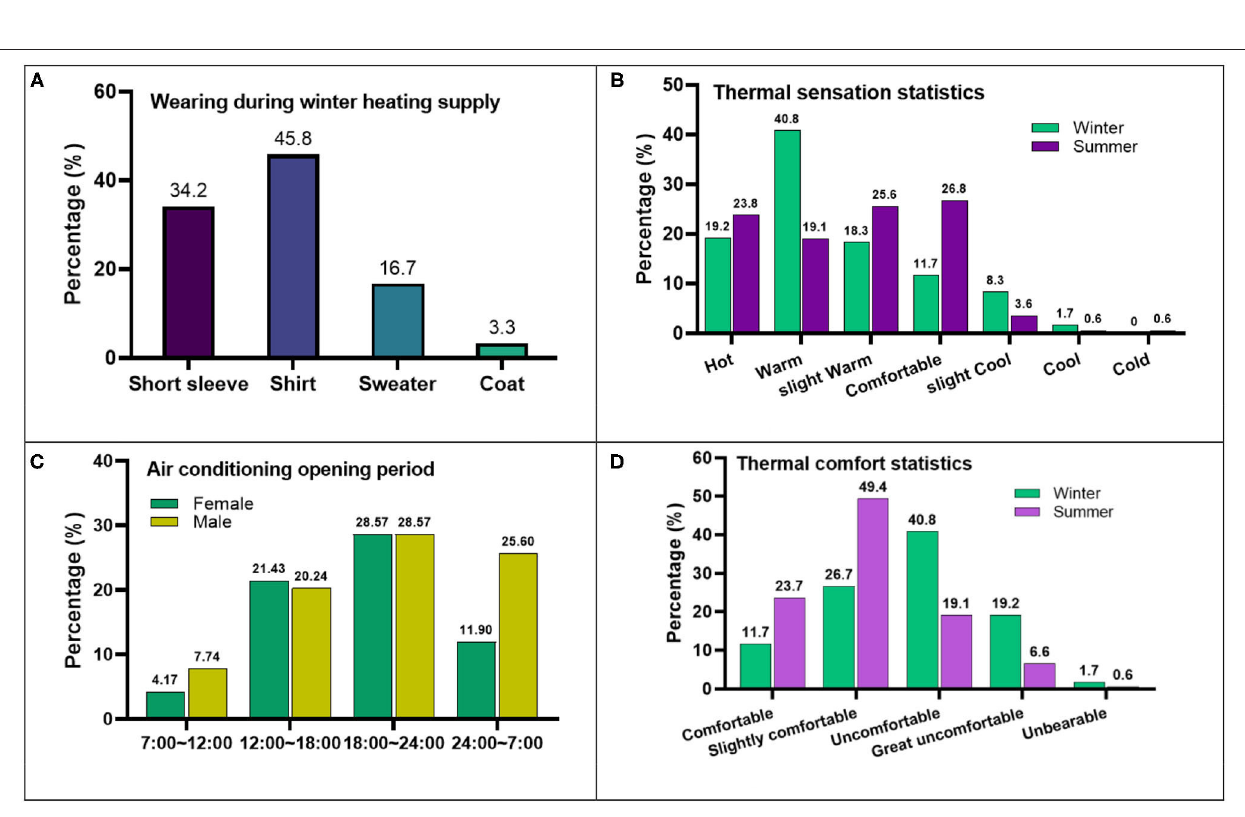
Frontiers in Public Health |